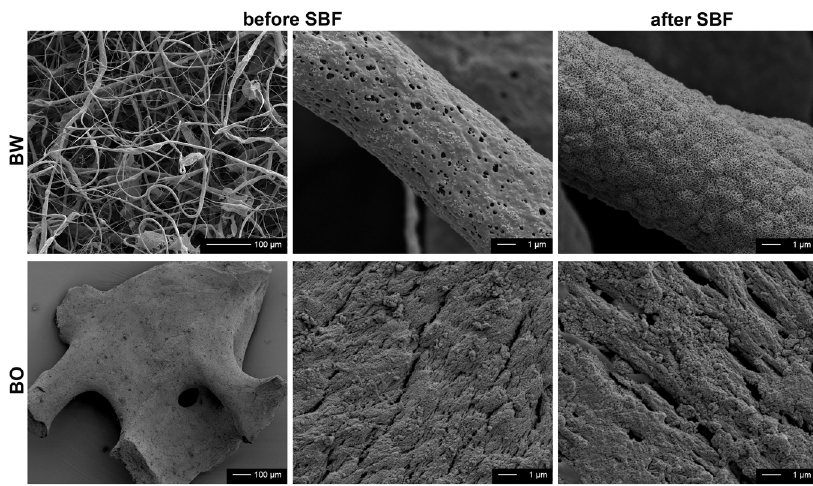
Fig. 7 SEM images of